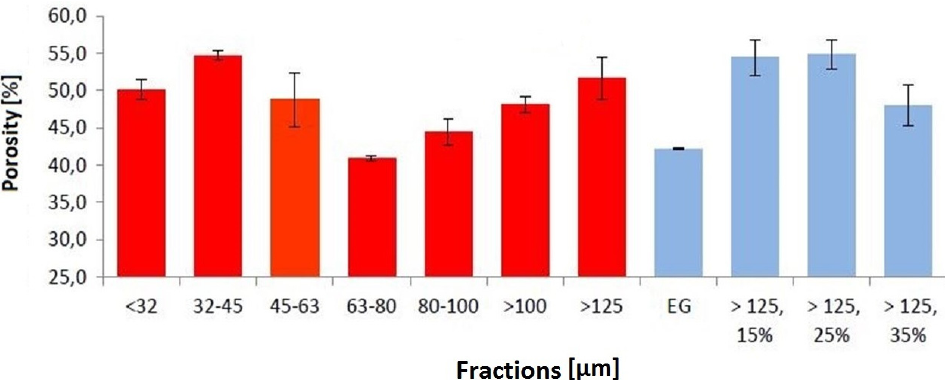
Figure 5. Porosity of 3D printed parts.